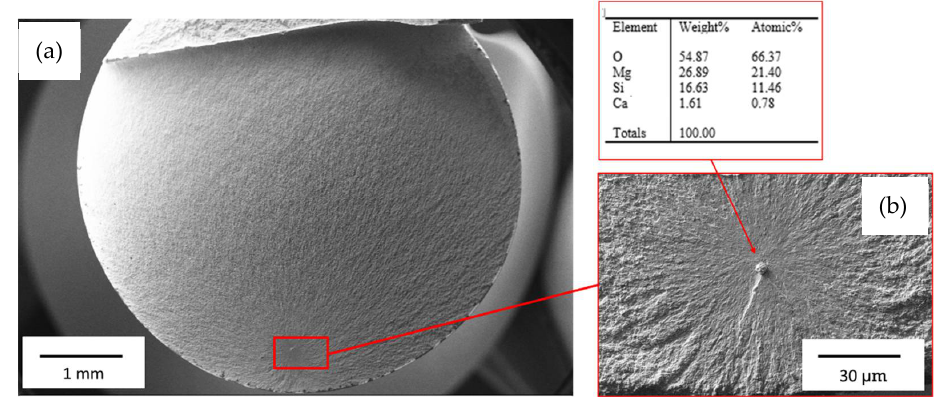
Figure 13. SEM-SE low magnification fatigue fracture surface of an unnotched sample (MPa 1100, cycles 5.4·10 6 ) with the crack initiation site in the sub-surface zone ( a ) and high magnification of the “fish-eye” with corresponding SEM-EDS analysis of non-metallic inclusion from which developed the “fish-eye” ( b ).